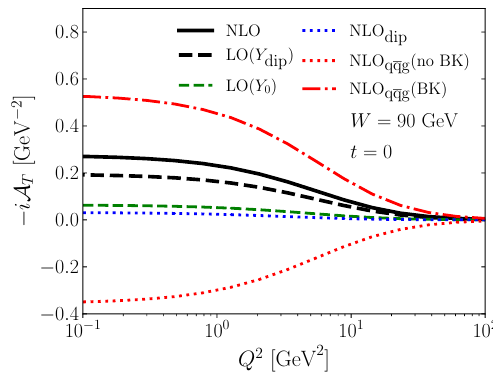
(b) Amplitude as a function of the photon virtu- ality Q 2 .